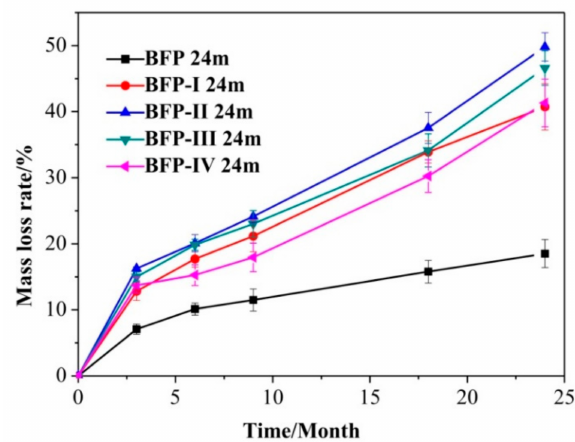
Figure 5. Mass loss rate of BFP, BFP-I, BFP-II, BFP-III, and BFP-IV composites. Error bars represent the standard deviation of actual test values ( n =